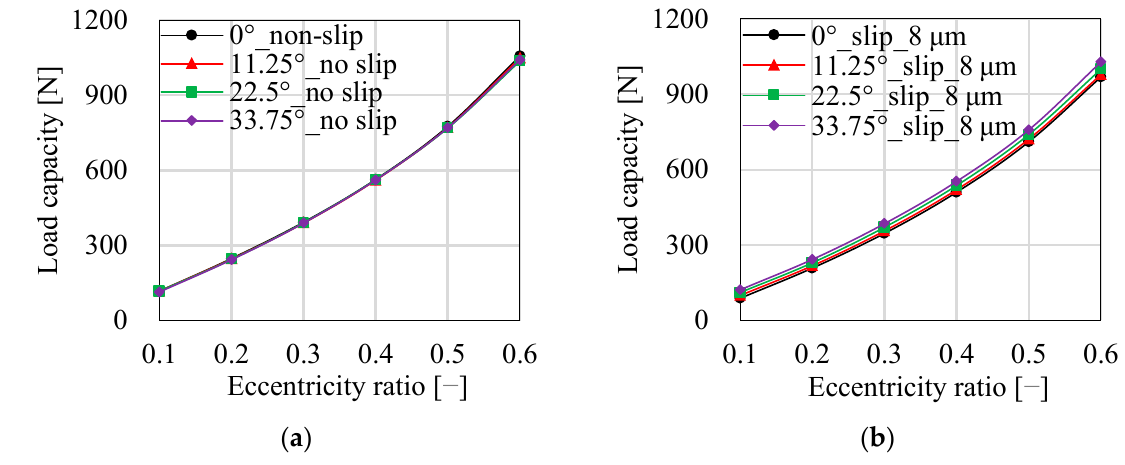
Figure 11. Comparison of load capacity under different attitude angle; ( a ) non-slip boundary condition; ( b ) slip velocity.